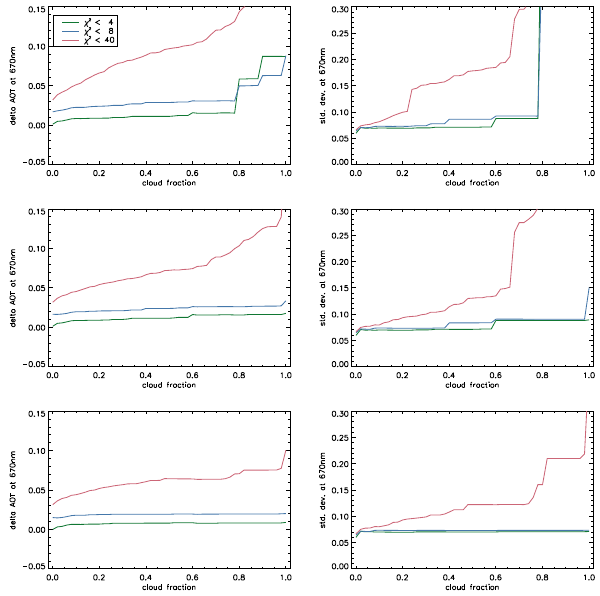
Figure 7. The mean AOT difference between PARASOL and AERONET (left panels) and the SD of the AOT differences between PARASOL and AERONET (right panels) in the 670nm band are shown cumulatively for increasing cloud fraction from MODIS, for three different χ 2 filters. The results of the top panels have only been filtered with the goodness-of-fit criteria, the middle panels have additionally been filtered on m coarse r > 1 . 335 and the bottom two panels are filtered on both the m coarse r > 1 . 335 and on the frac- tion of co-located MODIS pixels for which the cirrus reflectance flag was set ( f cirrus ≤ 10%).